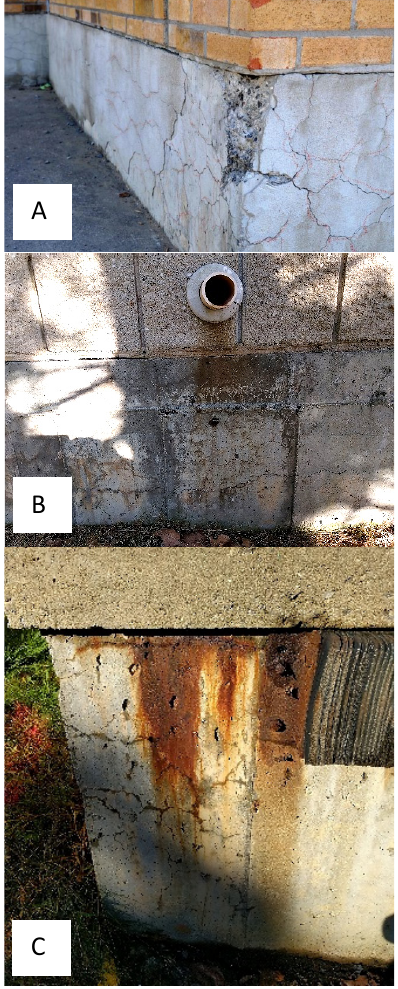
Figure 1. Typical signs of deterioration observed in a building containing iron-sulfide-bearing aggregates. A) Trois-Rivières, Canada. B and C) Connecticut,